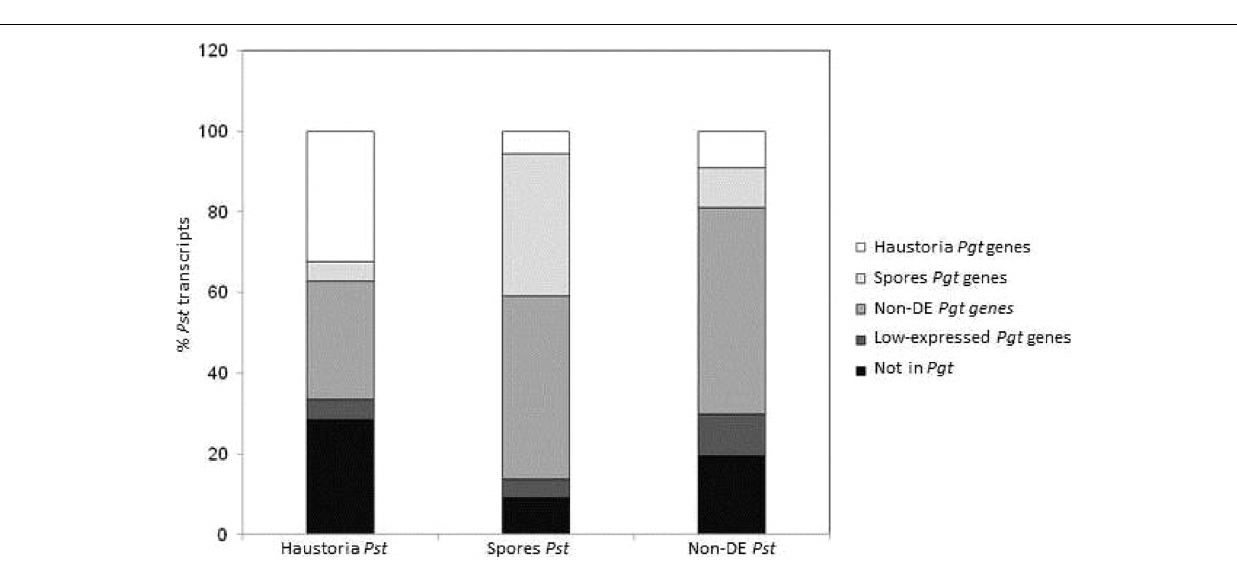
FIGURE 4 | Comparison of gene expression profiles in Pgt and Pst in haustoria and germinated spores stages. A total of 12,282 transcripts from Pst previously classified accordingly to their statistically significant over expression in germinated spores (2,357) and haustoria (1,989), or those that